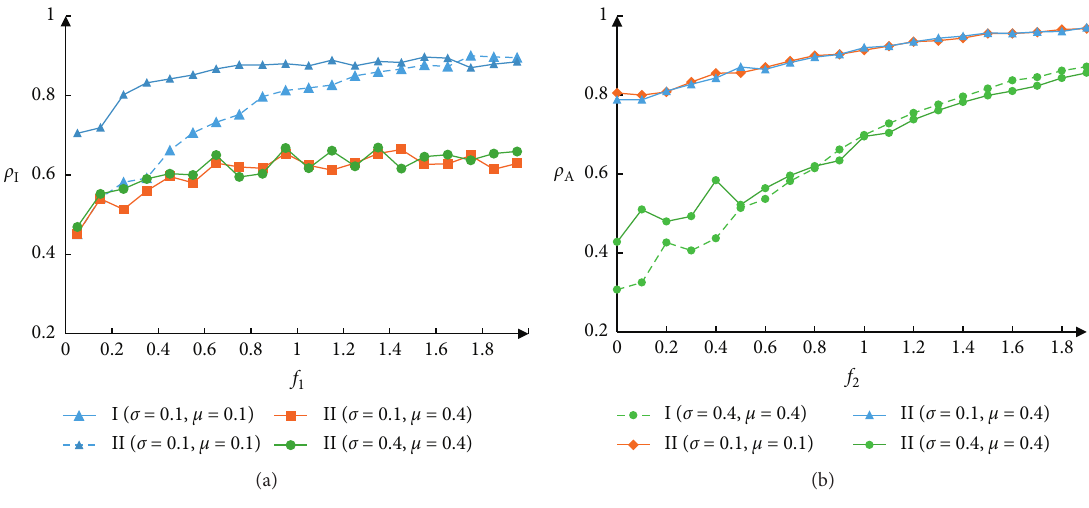
Figure 9: Impact of influence factors on the scale of